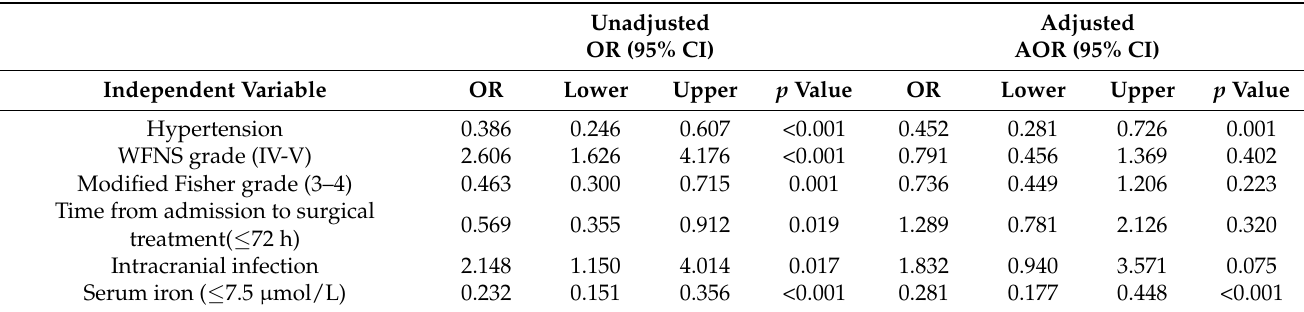
Table 2. Predictors for DCI of aSAH in multivariate model.